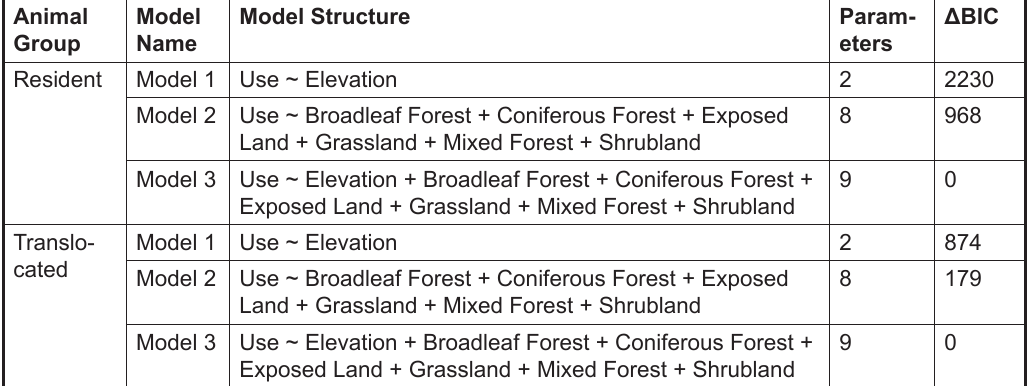
Table 2: Model structure and BIC model competition results for competing habitat selection models fit to data from resident Columbia North caribou and caribou translocated from the Purcells-South and South Selkirks populations. All models included a random effect of individual ID. The habitat reference category was comprised of habitat clas- sifications of water, wetland, rock and rubble, snow and ice, herbaceous, unclassified, and developed habitat types. Model 3 was the top performing model for both animal groups and used for subsequent